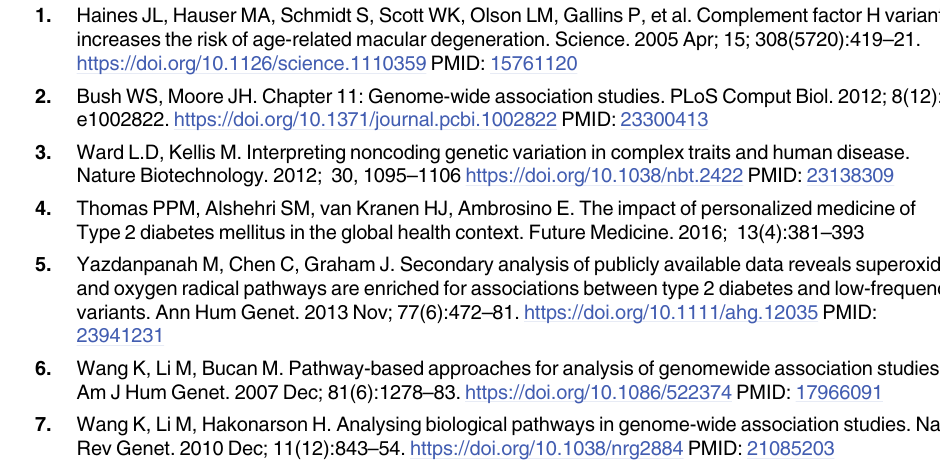
S7 Table. Meta-analysis on Genetic Association Studies Checklist from PLOS ONE.